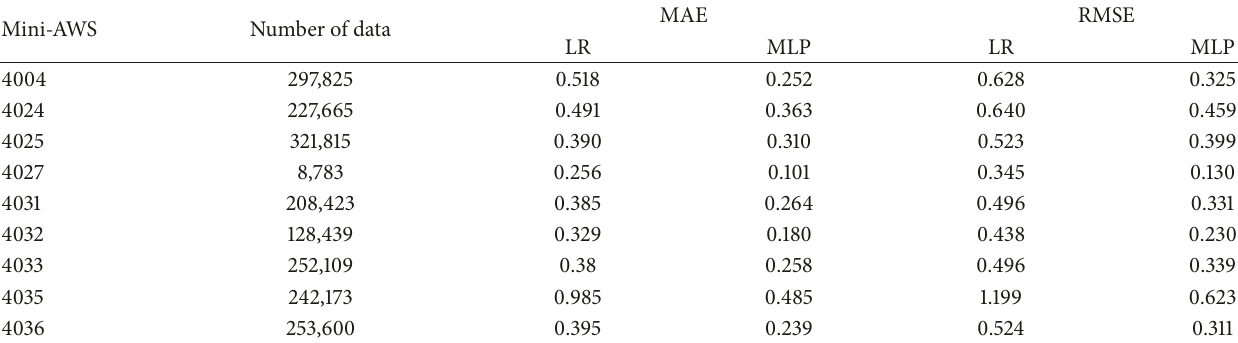
Table 2: Experimental results of the data divided into Mini-AWSs.